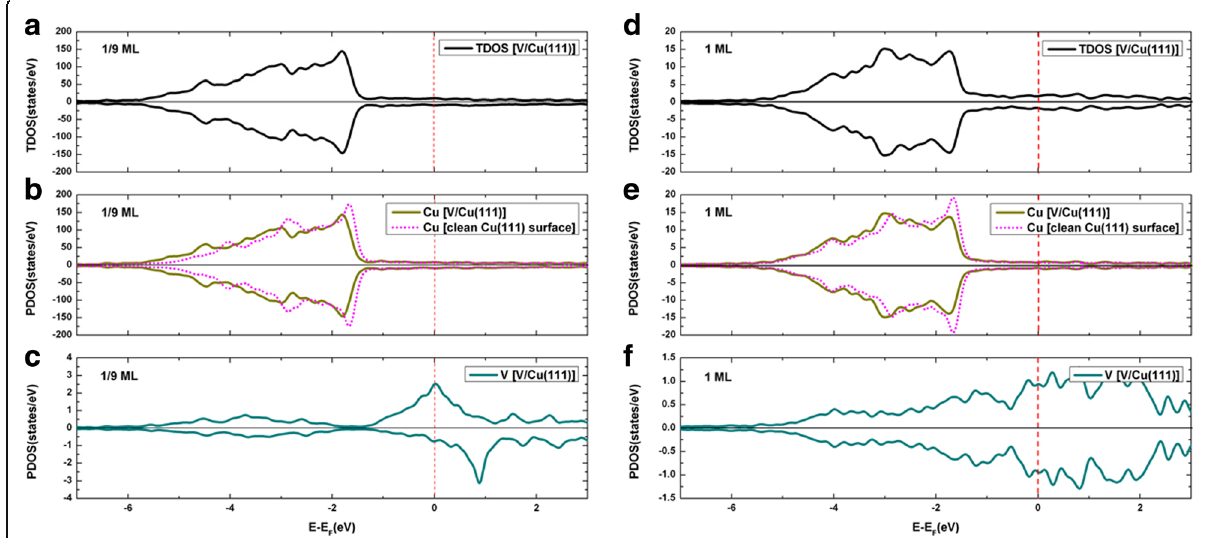
Fig. 4 a TDOS of V/Cu(111) system at 1/9 ML coverage; b PDOS of overall Cu atoms of substrate at 1/9 ML; c PDOS for V adatom at 1/9 ML; d TDOS of V/Cu(111) system at 1 ML; e PDOS for overall Cu atoms of substrate at 1 ML; and f PDOS for V adatoms at 1 ML. Notably, the DOS of clean Cu(111) surface is also implanted in graphs b and e for